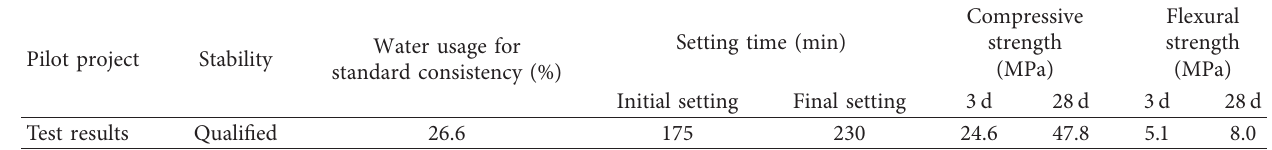
Table 1: Measured properties of P • O 42.5 cement.